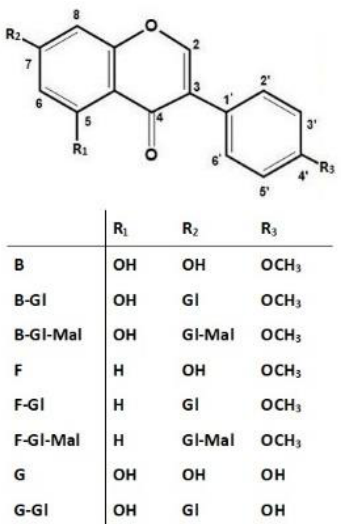
Figure 2. Chemical structure of isoflavones identified in TML. Explanation of compound name